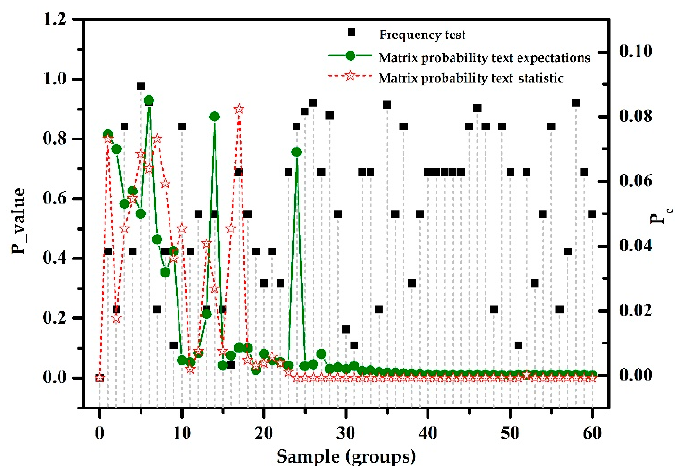
Figure 3. Lightweight encryption algorithm.